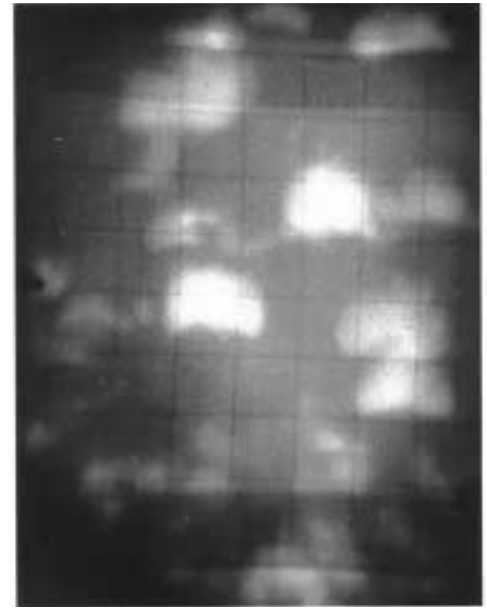
Fig. 1 X-ray image of a freely bubbling fluidized bed [3]